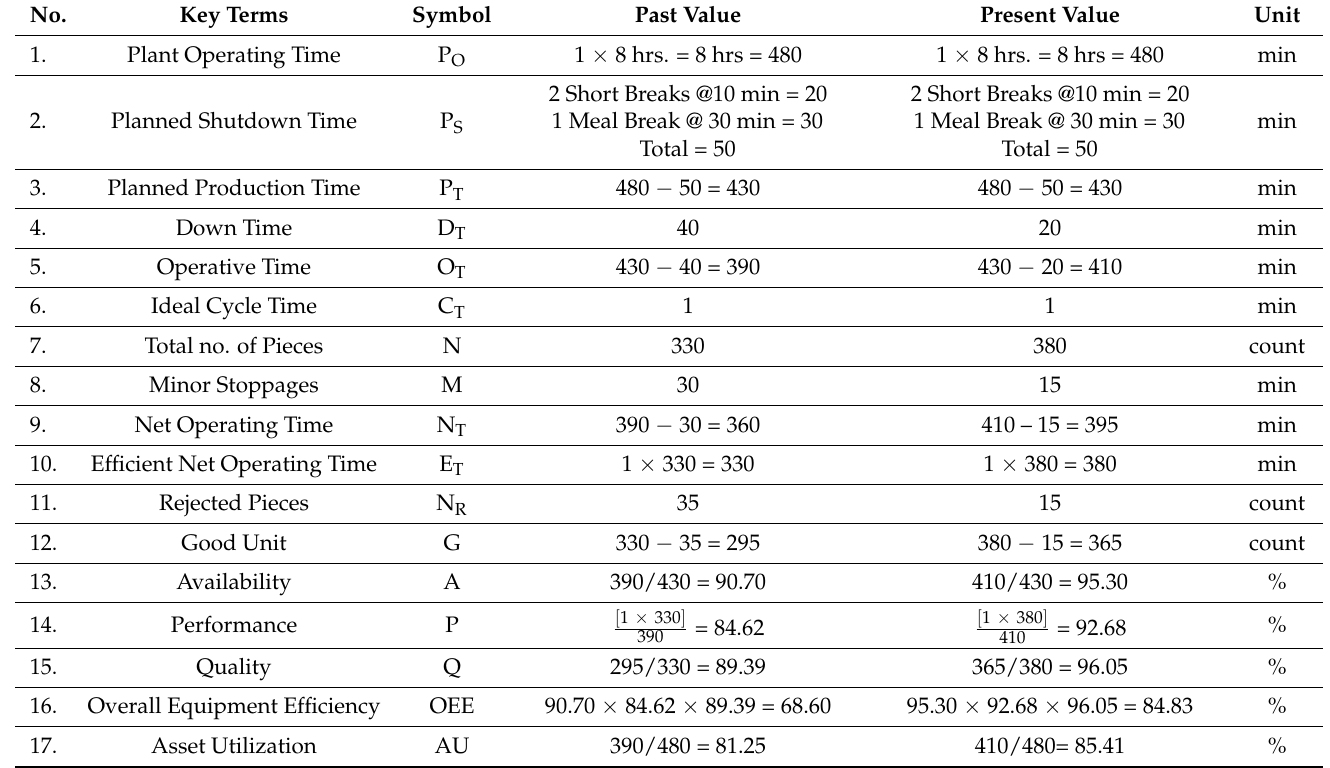
Table 4. Improved key